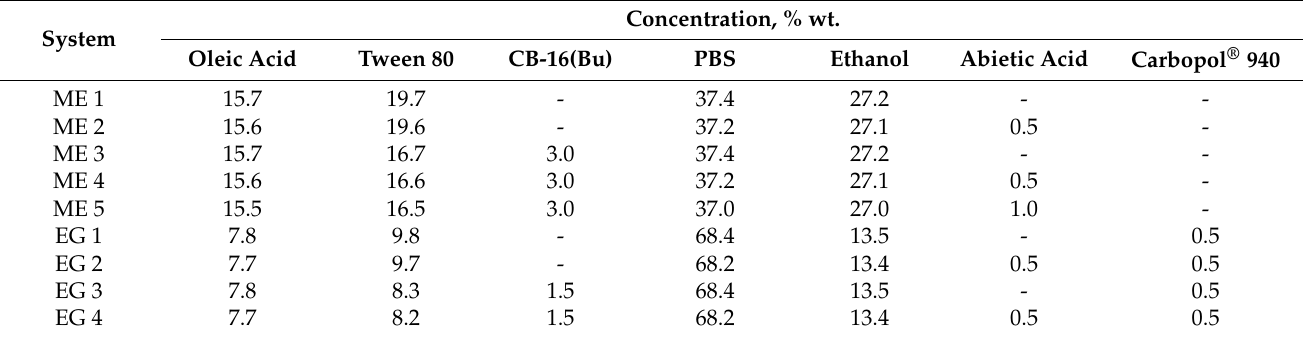
Table 1. Composition and designations of the formed microemulsions and emulgels. Concentration, % System